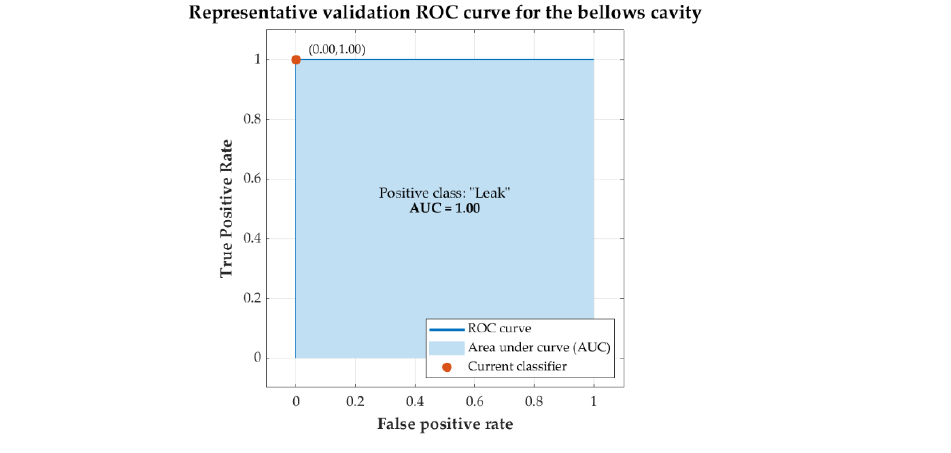
Figure 9. Representative validation ROC curve obtained for the bellows cavity model with logistic regression with input features b 1 , b 4 , and b 6 .